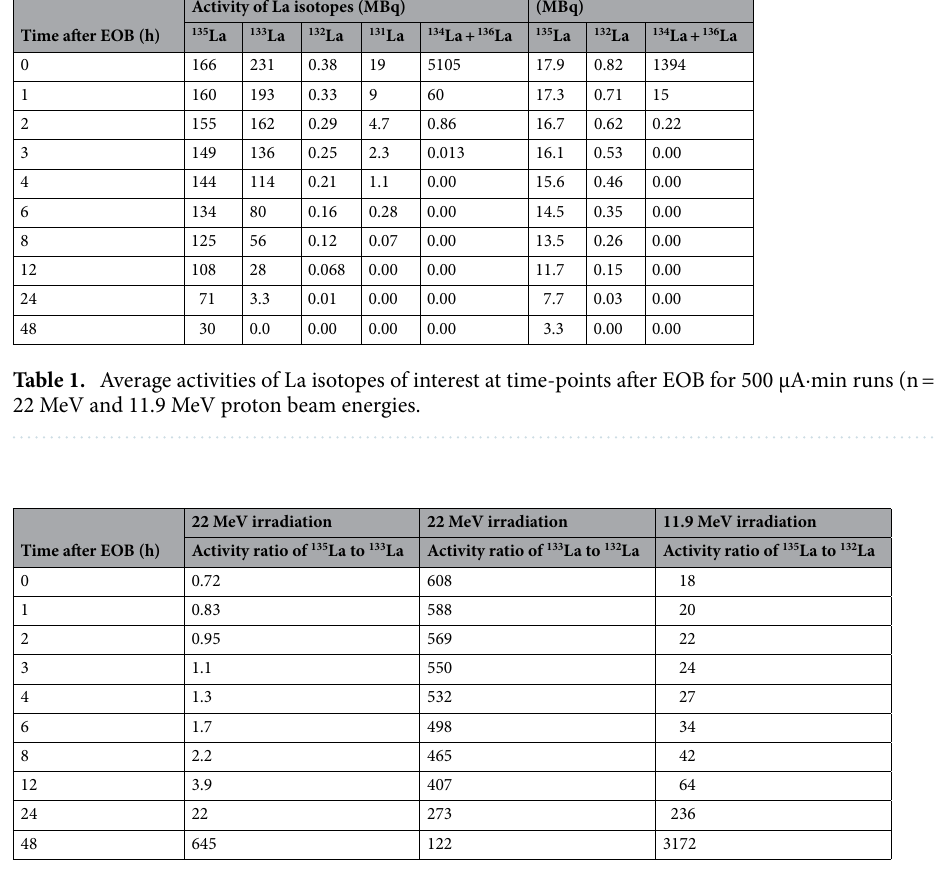
Table 2. Activity ratios of La isotopes of interest at time-points after EOB for 500 µA·min runs (n = 3) at 22 MeV and 11.9 MeV proton beam energies.